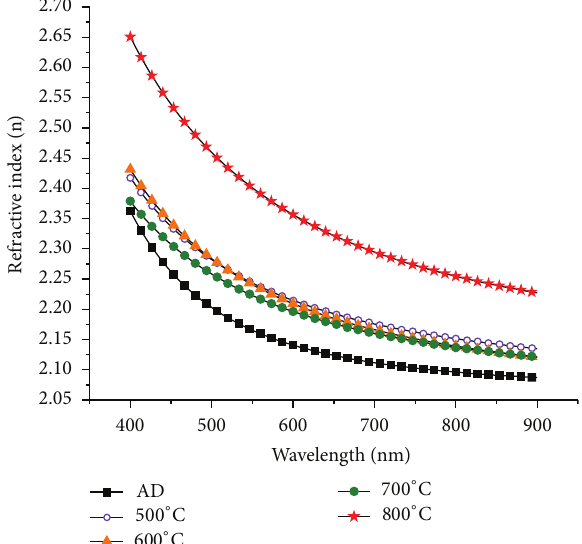
Figure 8: Refractive index of all samples as a function of wavelength calculated from the Cauchy model showing higher values for samples annealed at 800 ∘